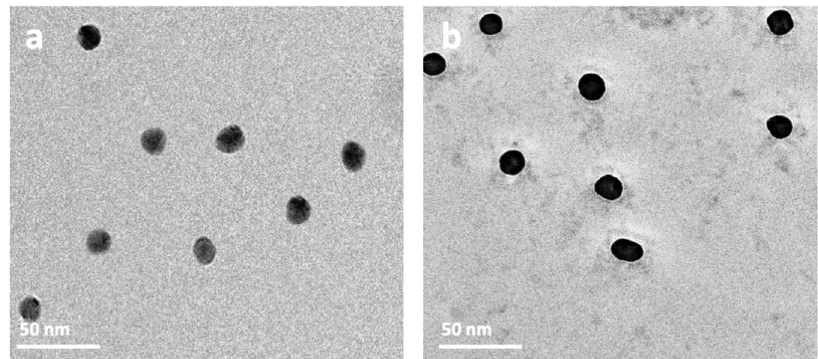
Fig. 6 Cryo-EM images of 15-nm gold NPs. a NPs without BC and b NPs with BC. Note the occurrence of biomolecules in the plasma residue in the